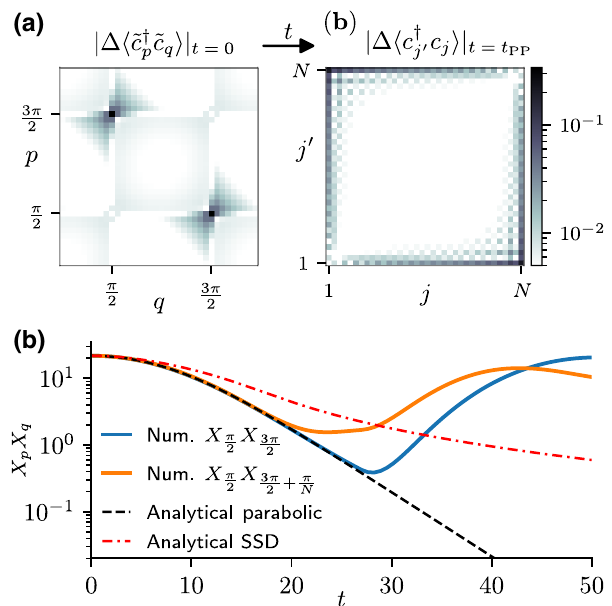
FIG. 4. Mode mapping from the momentum to the position space for the fermionic chain with size N = 36 during the evo- lution under the parabolically deformed Hamiltonian. (a) Initial deviation of the correlator in the OBC GS from the target value in the momentum space, and (b) the deviation of the correlator in the position space at time t PP from Fig. 3(a). (c) Contribution of quasiparticles with momenta q , p to the two-point correlators in the subsystem A corresponding to the sites { 5, . . . , 32 } . The black dashed and red dash-dotted lines show the analytical result [see the discussion around Eq. (A17)] for the parabolic and SSD deformations,